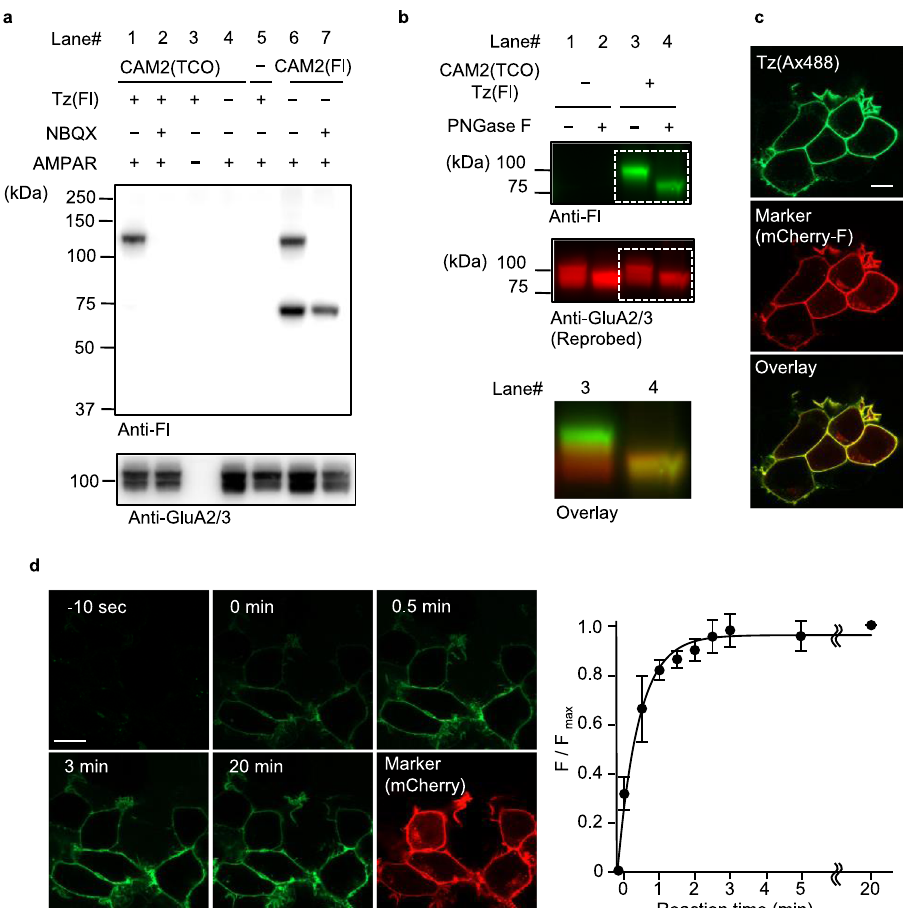
Fig. 2 The two-step labeling of cell-surface AMPARs ectopically expressed in HEK293T cells. a Western blotting analyses of HEK293T cells after the two-step labeling. HEK293T cells transfected with GluA2 fl ip (Q) (AMPAR( + )) or vector control (AMPAR( − )) were treated with 2 μ M CAM2(TCO) for 4 h followed by the addition of 1 μ M Tz(Fl) for 5 min, or treated with 2 μ M CAM2(Fl) for 4 h in the presence or absence of 50 μ M NBQX in culture medium at 37 °C. The cell lysates were analyzed by western blotting using anti- fl uorescein or anti-GluA2/3 antibody. Quanti fi cation of the band intensity is shown in Supplementary Fig. 3. When CAM2(Fl) is added in serum free medium, strong bands around 70 kDa in lane #6 and #7 disappear (for details see ref. 26 ). b Effects of PNGase F treatment on the western blotting of labeled AMPAR in HEK293T cells expressing GluA2. Lower image shows the overlay of anti-Fl image and anti-GluA2/3 image for lane #3 and #4. Two-step labeling was conducted as described in ( a ). PNGase F (1000 units/100 μ L) was added to the cell lysate. For details, see Methods section. c Confocal live imaging of the HEK293T cells labeled with 2 μ M CAM2(TCO) and 0.1 μ M Tz(Ax488). Labeling was conducted as described in ( a ). mCherry-F was utilized as a transfection marker. Scale bars, 10 μ m. d Reaction kinetics of tetrazine ligation on live cells by confocal live imaging of the HEK293T cells labeled with 2 μ M CAM2(TCO) after addition of 0.3 μ M Tz(Ax488) at 37 °C. In left, confocal images are shown. Scale bars, 20 μ m. In right, time-course of the fl uorescent intensity of Alexa 488 is shown ( n = 6 cells). Data are represented as mean ±